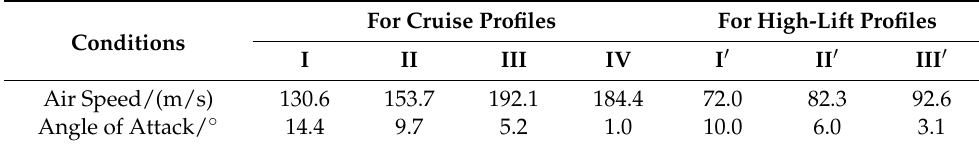
Table 2. List of defined extreme conditions both for cruise and high-lift profiles. Conditions